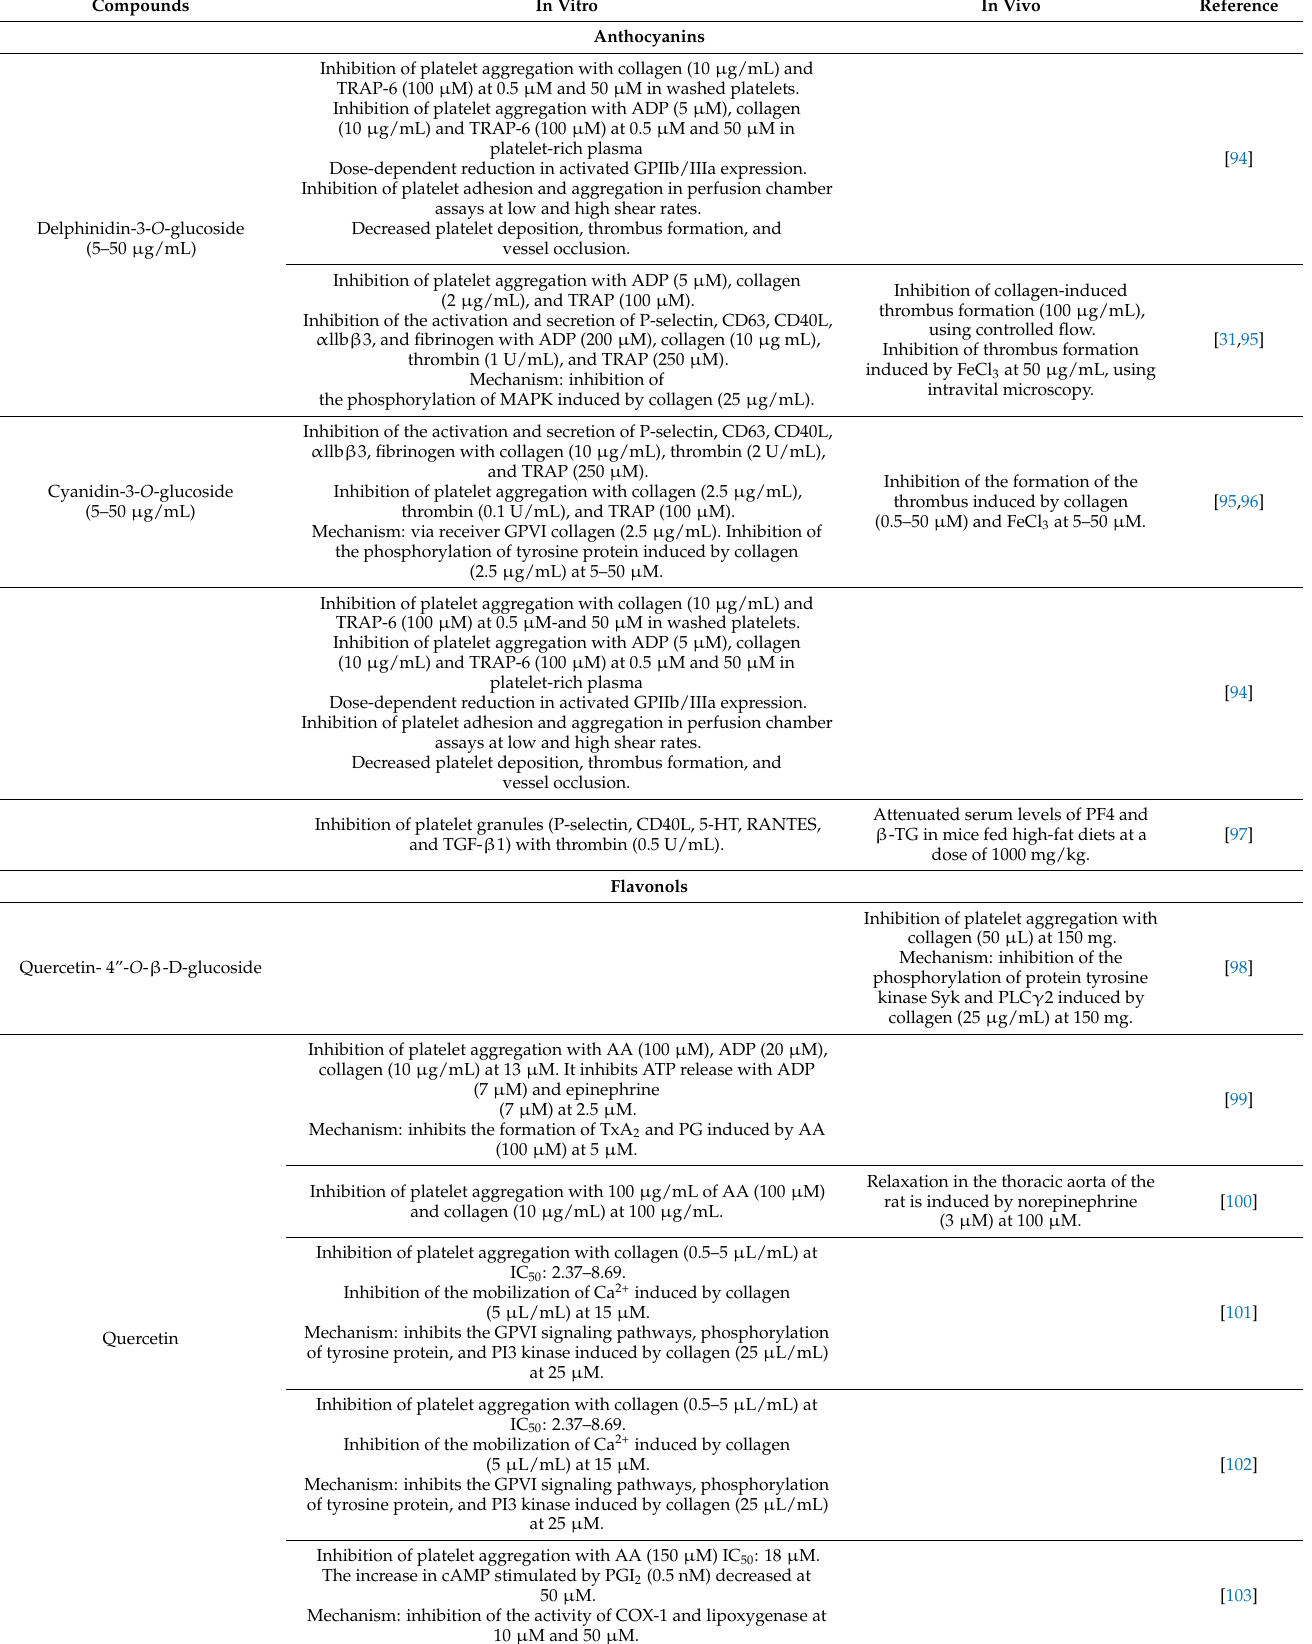
Table 3. Antiplatelet activity of anthocyanins and phenolic compounds in Maqui. Compounds In Vitro In Vivo Reference Anthocyanins